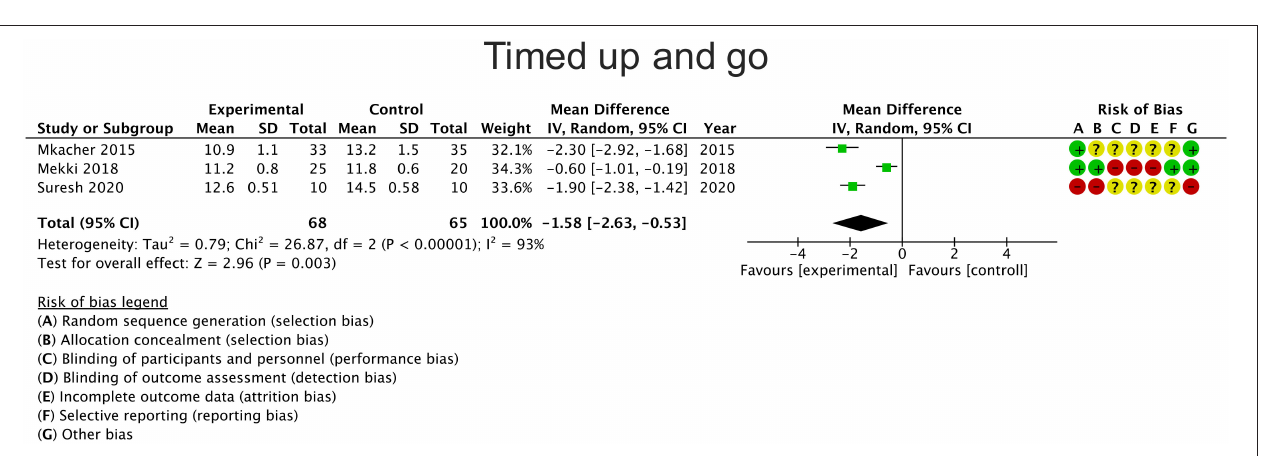
25) as they compared the intervention with a control